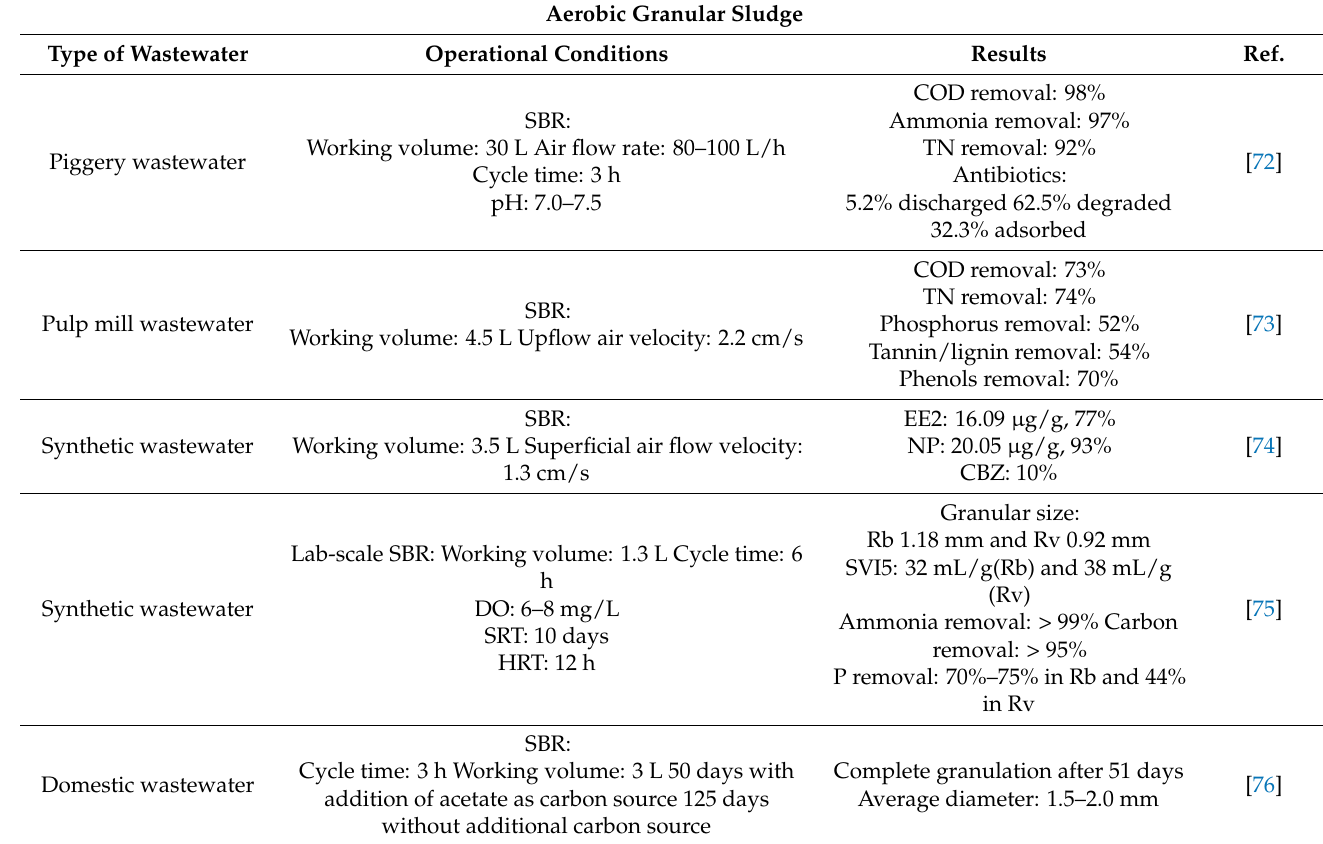
Table 4. Example applications of aerobic and anaerobic granular sludge in wastewater treatment. Aerobic Granular